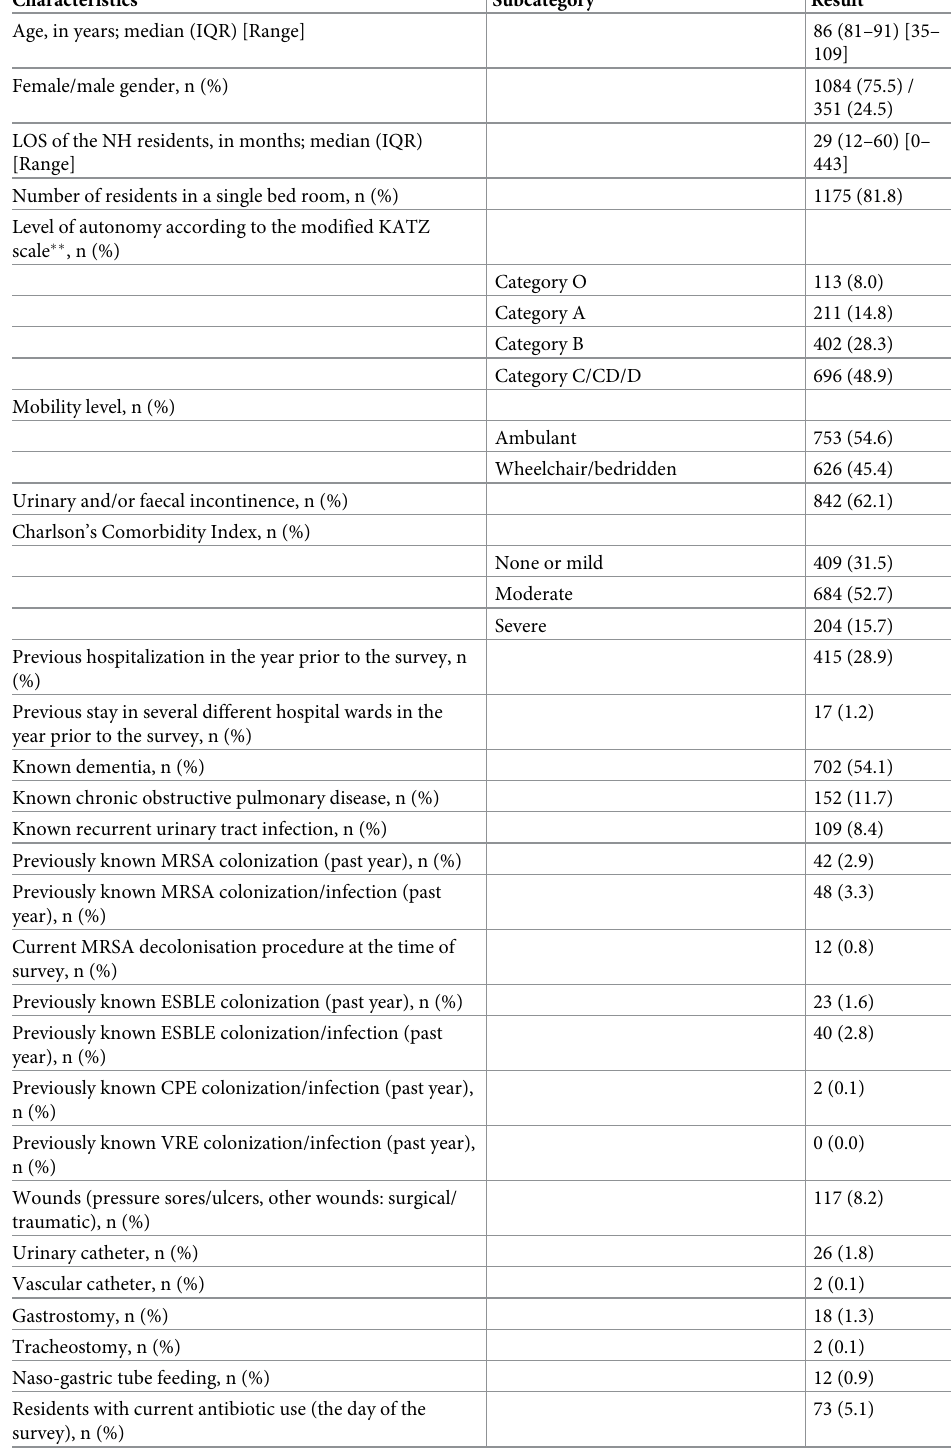
Table 1. Characteristics of residents (n = 1441) included in a point prevalence survey conducted in 29 Belgian nursing homes,